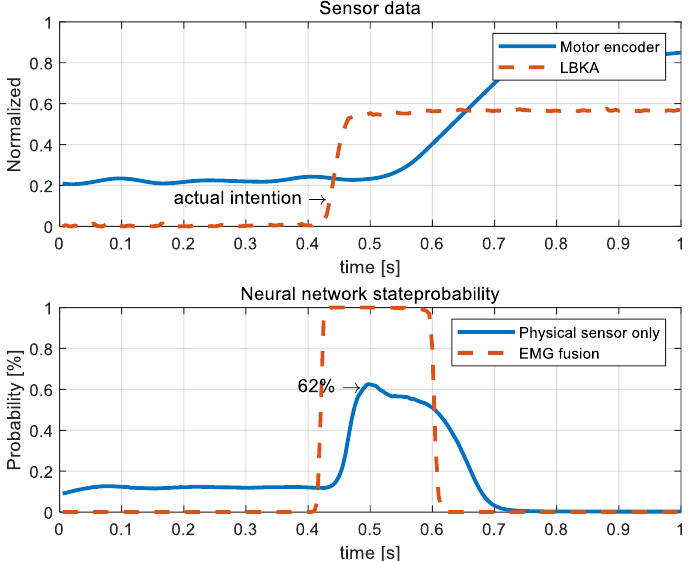
Figure 12. A graph of the measured sensor values and NN results. The probability output by the NN with the physical sensor was lower than even the malfunctioned case of Figure 11 when there was an actual intention. The probability of the NN with EMG fusion was calculated as high when there was an actual intention.